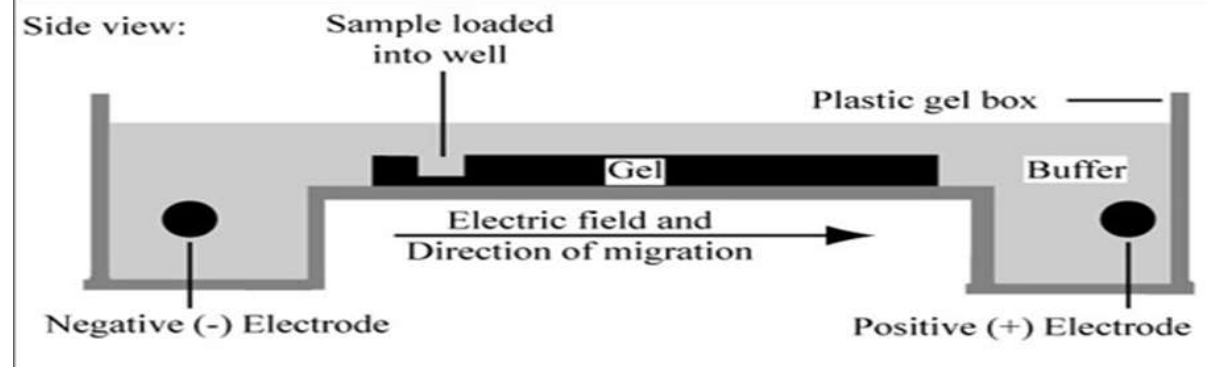
Figure 1: The agarose gel electrophoresis system. (Figure by MIT Open Courseware.).